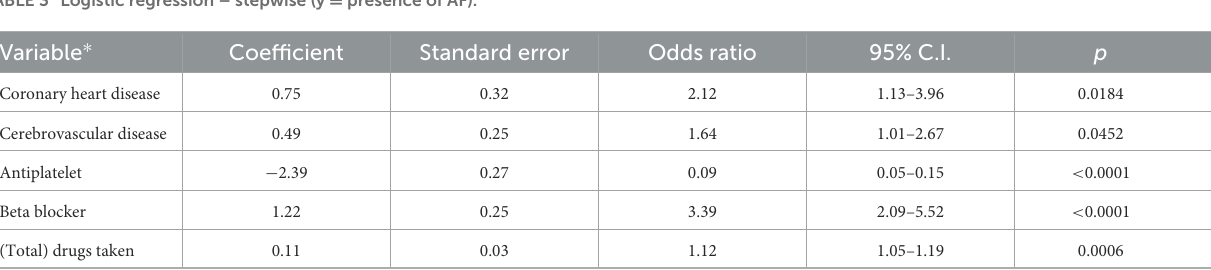
TABLE 3 Logistic regression – stepwise (y = presence of